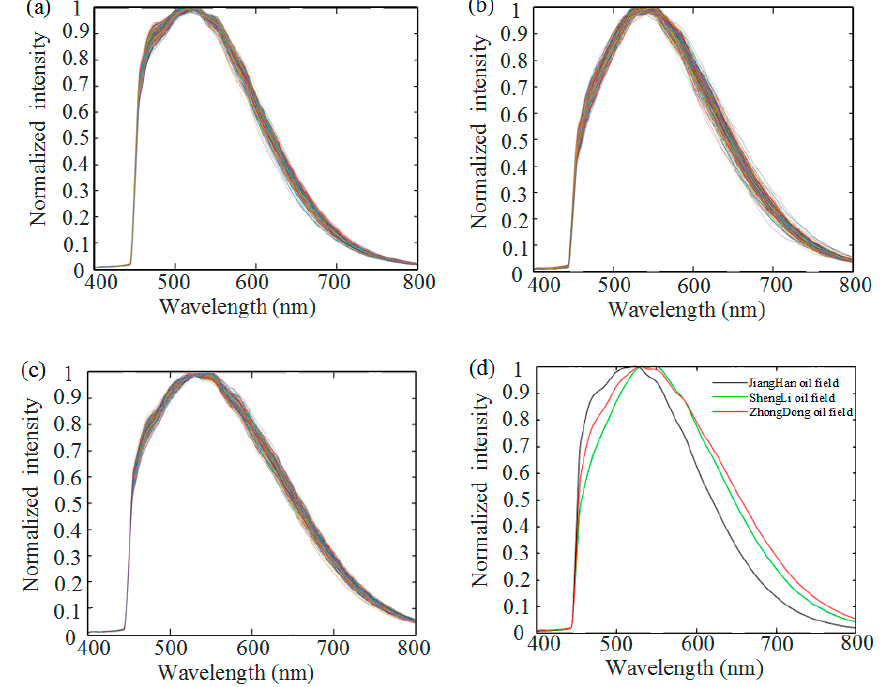
Figure 4. Normalized spectra of three types of crude oils. ( a ) Crude Oil 1. ( b ) Crude Oil 2. ( c ) Crude Oil 3. ( d ) The averaged normalized spectrum of the three types of crude oil.